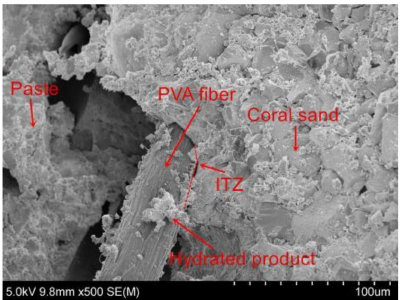
Figure 13. The interfacial transition zone between PVA fibers and the coral cement